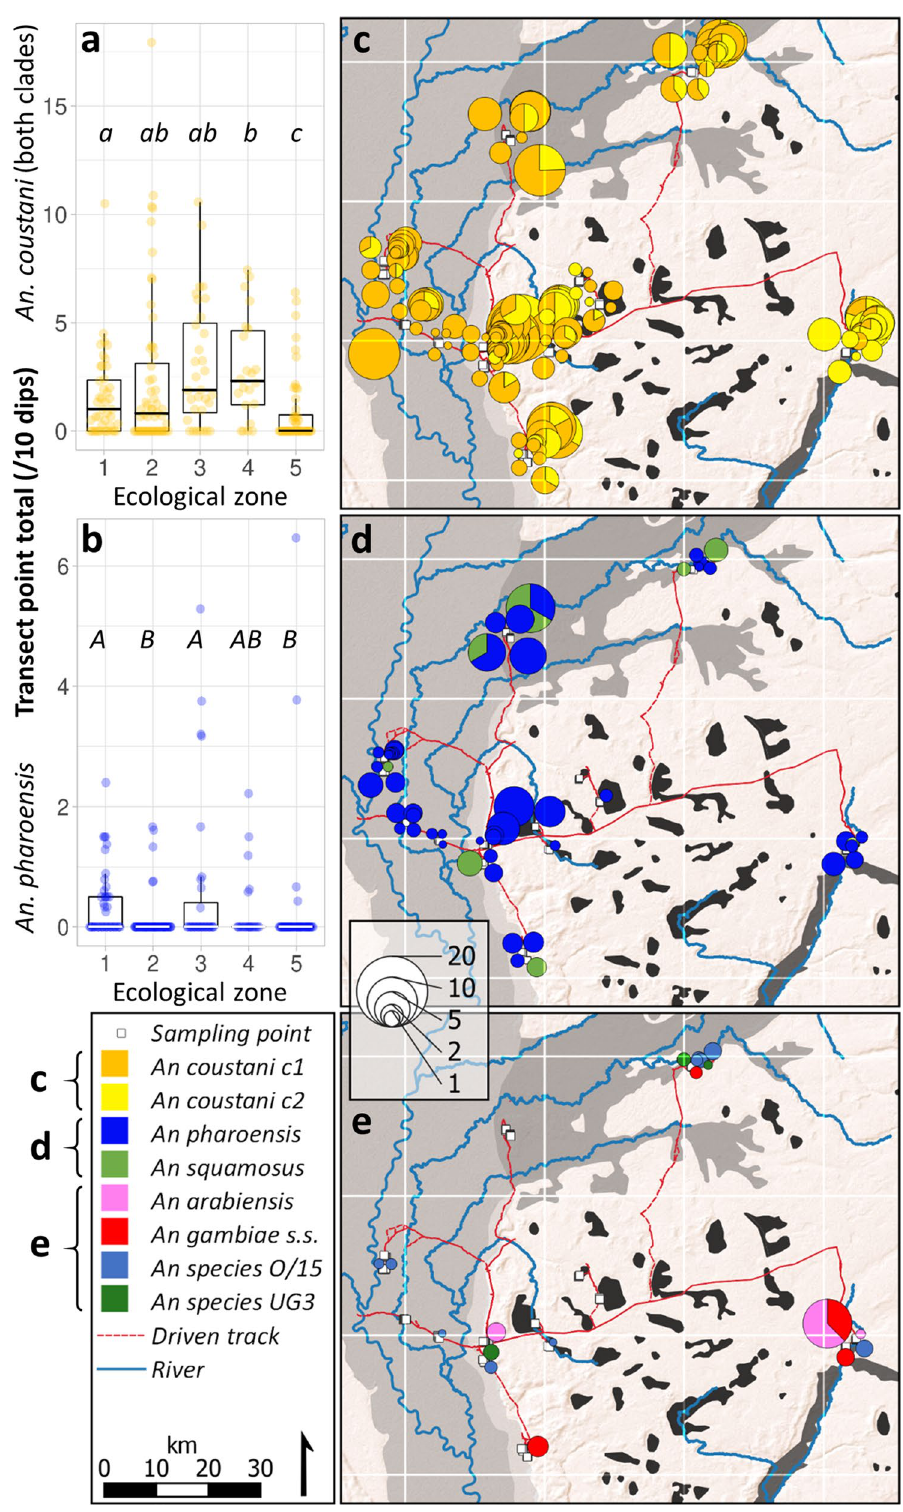
Figure 5. Distribution of anopheline larvae across ecological zones after peak of 2019 wet season. Species identities assigned from matches to COI and/or ITS2 sequences from GenBank. ( a–b ) Species abundance across ecological zones. Ecological zones as per Fig. 1 and boxplot format as per Fig. 2. Ecological zones not sharing a letter are significantly different; lower case letters = independent samples median test; upper case letters = Kruskal–Wallis distribution test; stepwise step- down comparisons with adj p < 0.001. (c-e ) Spatial distribution of species across ecological zones (see Fig. 1). Symbol area proportional to estimated total larvae of mapped species per transect point (product of total anopheline count and taxa proportions in subsample), standardized per ten dips. Map drawn in QGIS 94 (v. 3.18.3-Zürich; https:// www. qgis. org); basemap: ESRI Shaded Relief